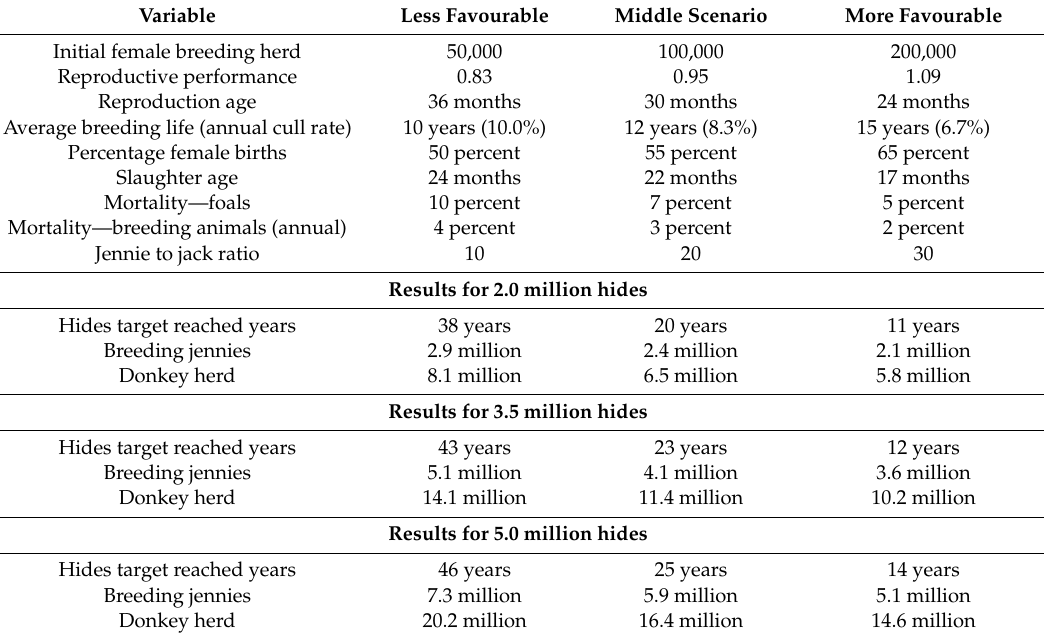
Table 3. Summary of farming model parameter values and results for hide production of 2.0, 3.5 and 5.0 million